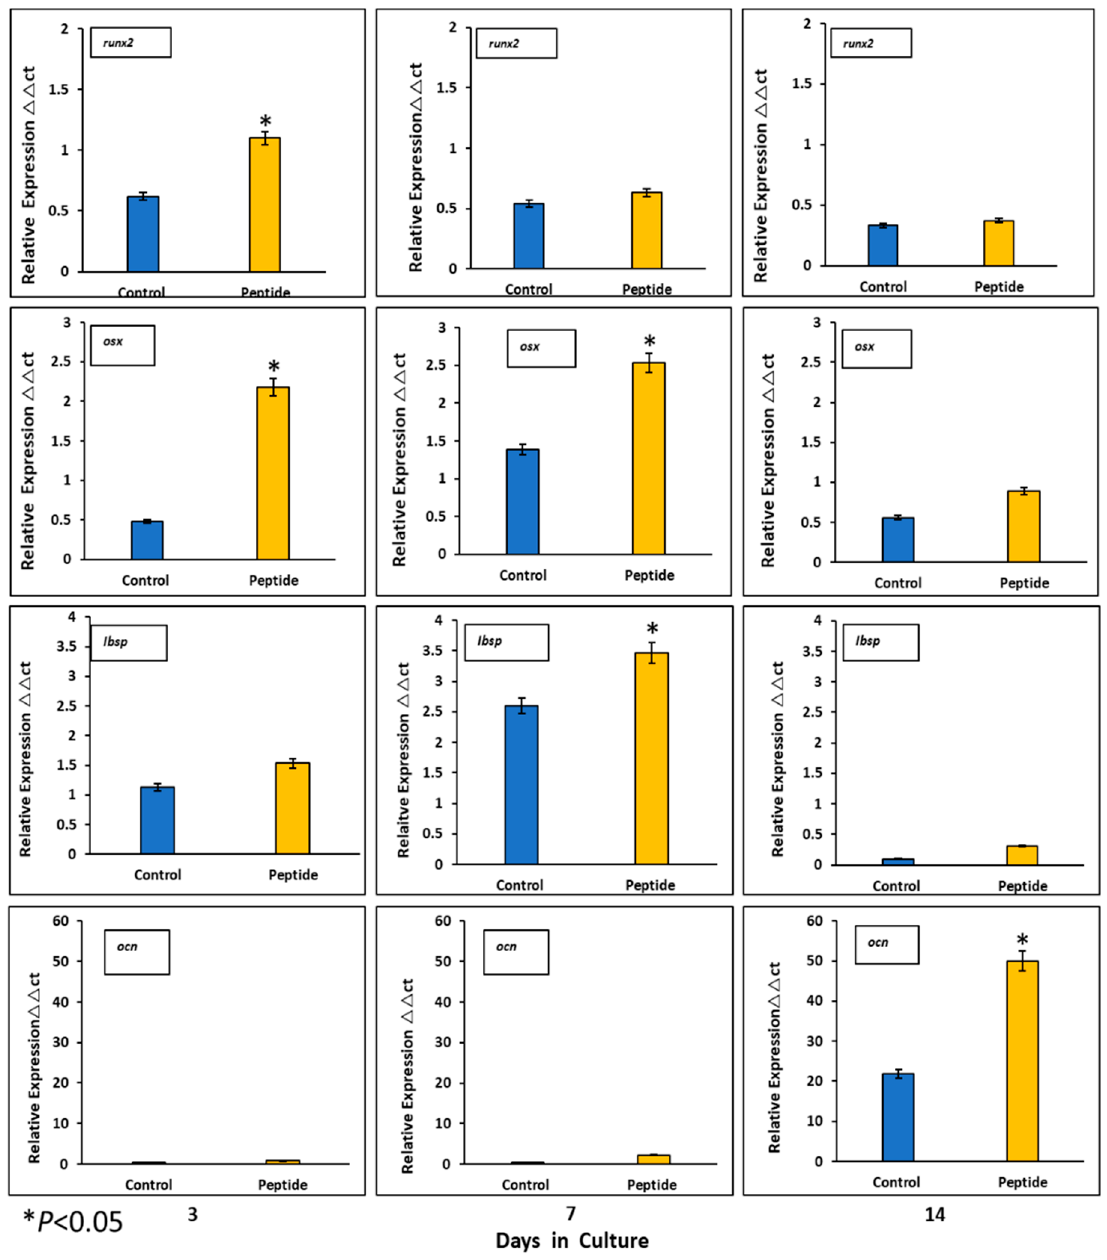
Figure 6. Expression of mineralization-related markers at the mRNA level. CEMP-1-p4 induced higher expression of core-binding factor subunit alpha-1 (RUNX2) and osterix (OSX) on days 3 and 7. Integrin-binding sialoprotein (IBSP) was highly expressed at the middle phase and osteocalcin (OCN) at the late stages of mineralization, when compared to controls. Identical triplicates were prepared for each reaction, and the experiment was repeated 3 times independently ( n = 3 / group). * p <